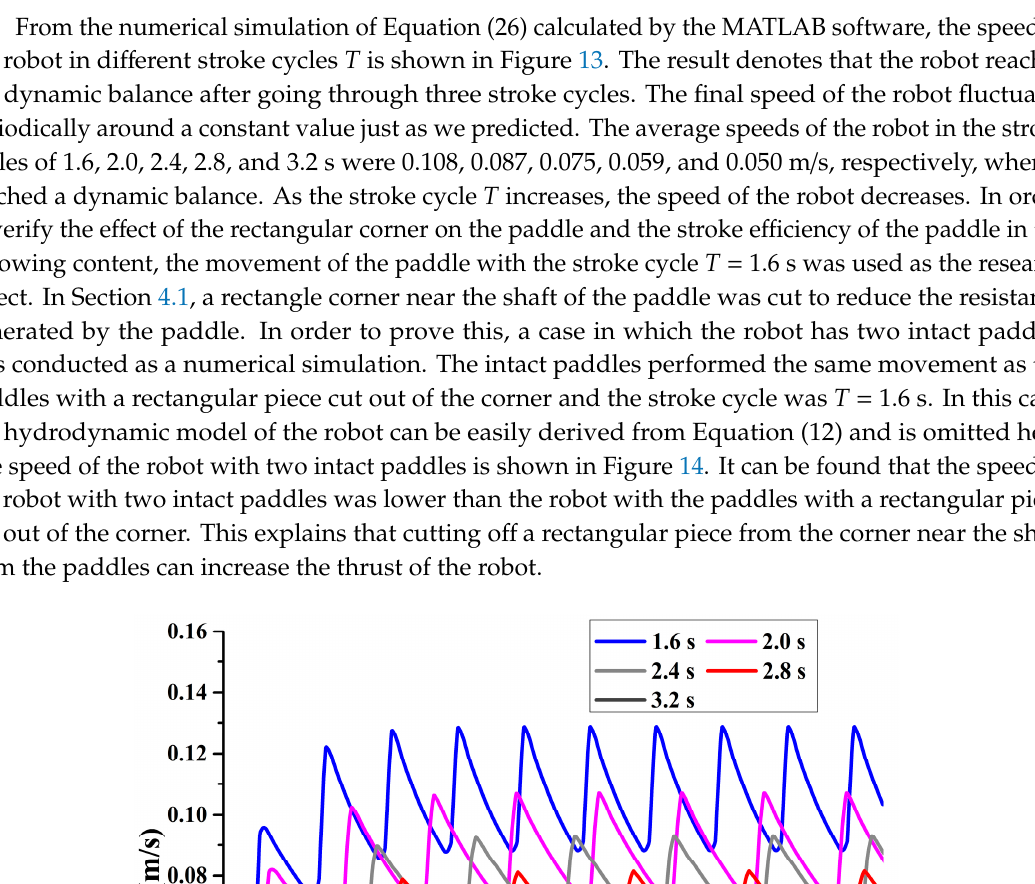
Figure 14. The speeds of the robot as a function of t at different situations. The solid black line is the speed of the robot when it performs an ellipse-like spatial stroke trajectory; the dashed blue line is the speed of the robot when it performs an ellipse-like spatial stroke trajectory with two intact paddles; the dotted green line is the speed of the robot when it performs a rectangle-like spatial stroke trajectory with two intact paddles. In order to evaluate the stroke efficiency of the robot when it performs the ellipse-like spatial stroke trajectory, another case was set up for comparison. In this case, the vertical translation and rotational movements of the paddle were alternating, but the vertical translation speed and rotational speed of the paddle were the same as the robot when it performs the ellipse-like spatial stroke